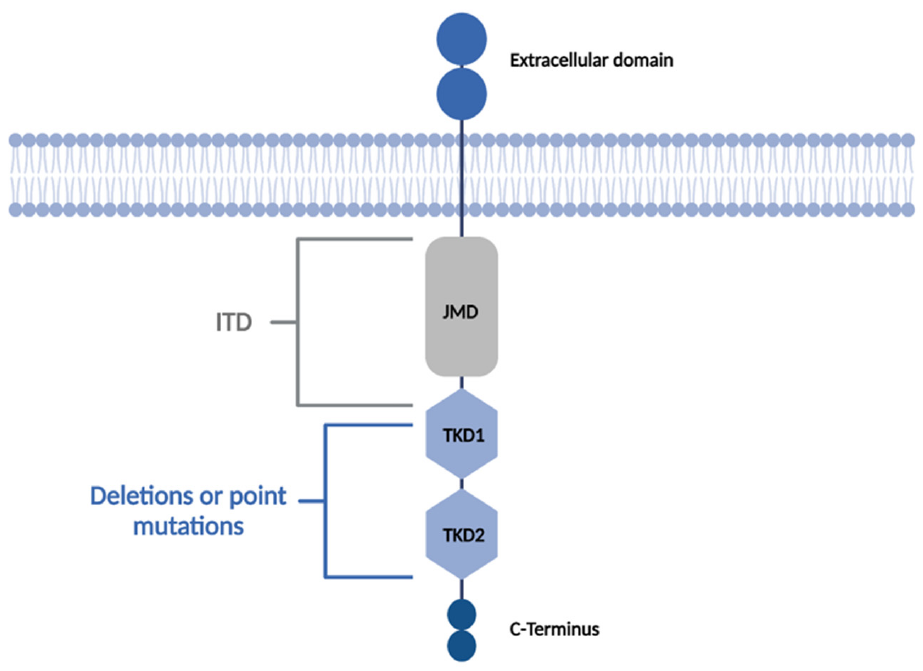
Figure 2. Schematic illustration of FLT3 tyrosine kinase displaying activating FLT3 mutations according to the affected receptor domain localization. FLT3 kinase comprises an extracellular domain, a transmembrane domain, a juxtamembrane domain (JMD), two tyrosine kinase domains (TKD1 and TKD2) and a C-Terminus. Internal tandem duplications (ITD) are usually located in the JMD whereas deletions and point mutations are mostly found in the TKD domains. Created with BioRender.com (accessed on 10 March